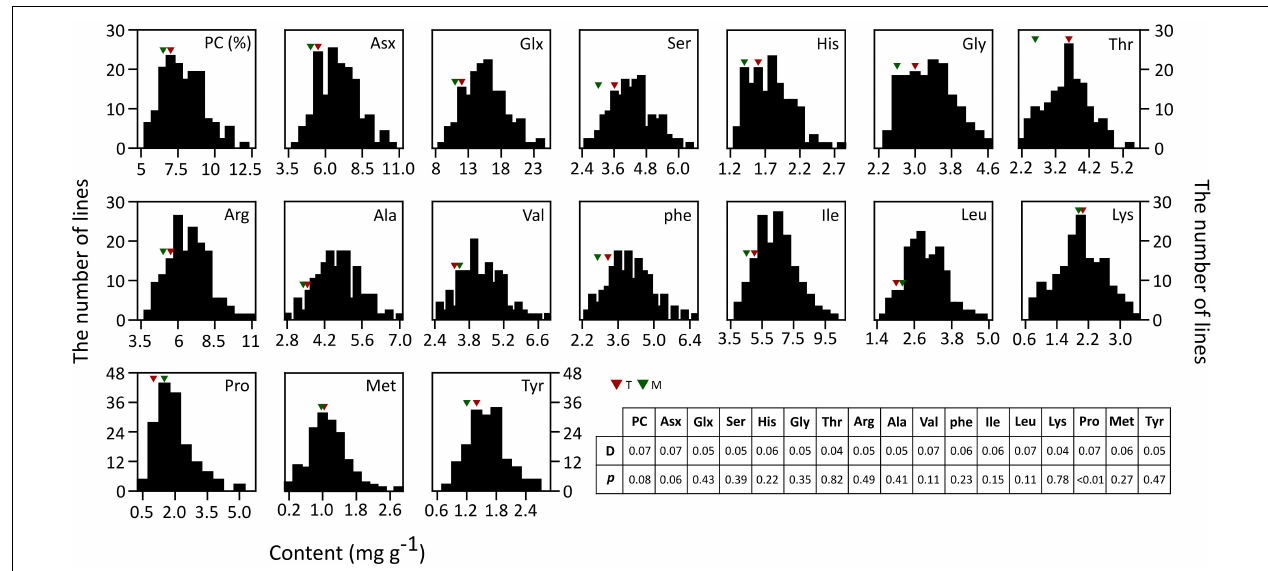
FIGURE 1 | Phenotypic distributions of 16 AACs and PC in brown rice of 155 RILs. Each AAC and PC is represented in percentage and mg/g, respectively. The result of Kolmogorov–Smirnov test used to test normality of distribution is shown in table ( p ≤ 0.05).